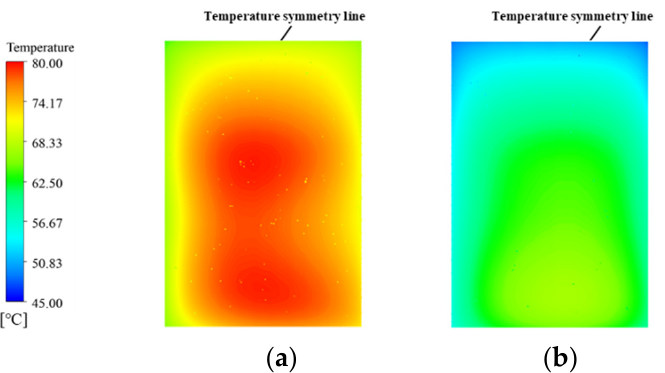
Figure 5. The temperature distribution of microchannel of the MMC and MMDC structures. ( a ) MMC; ( b ) MDMC.